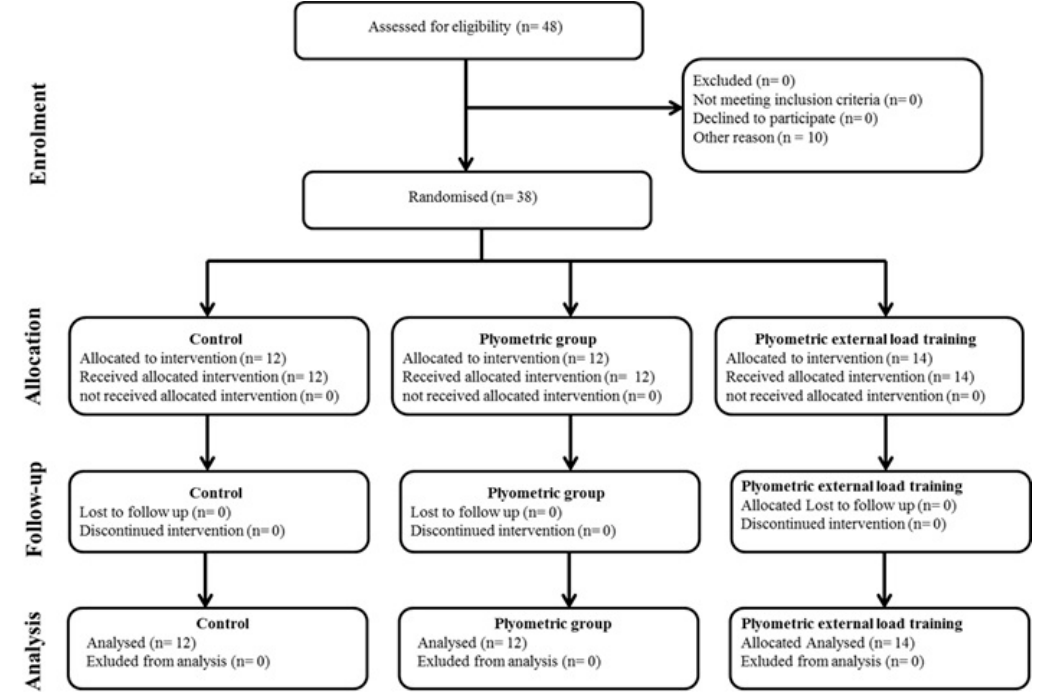
Figure 1. The diagram (The CONSORT: Consolidated Standards of Reporting Trials) includes detailed information on the interventions received.